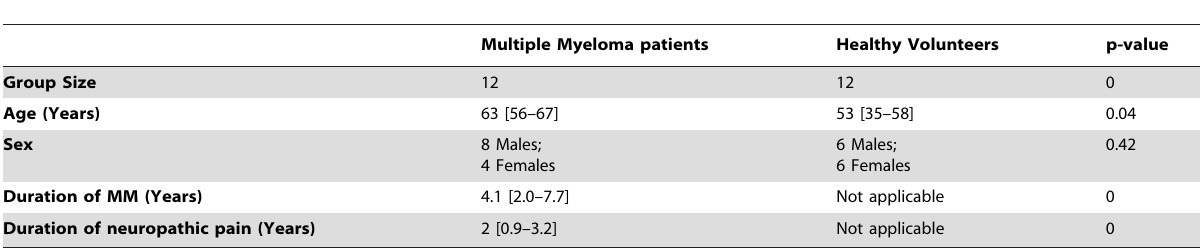
Table 1. Baseline characteristics (median [IQR]) of the subjects recruited.